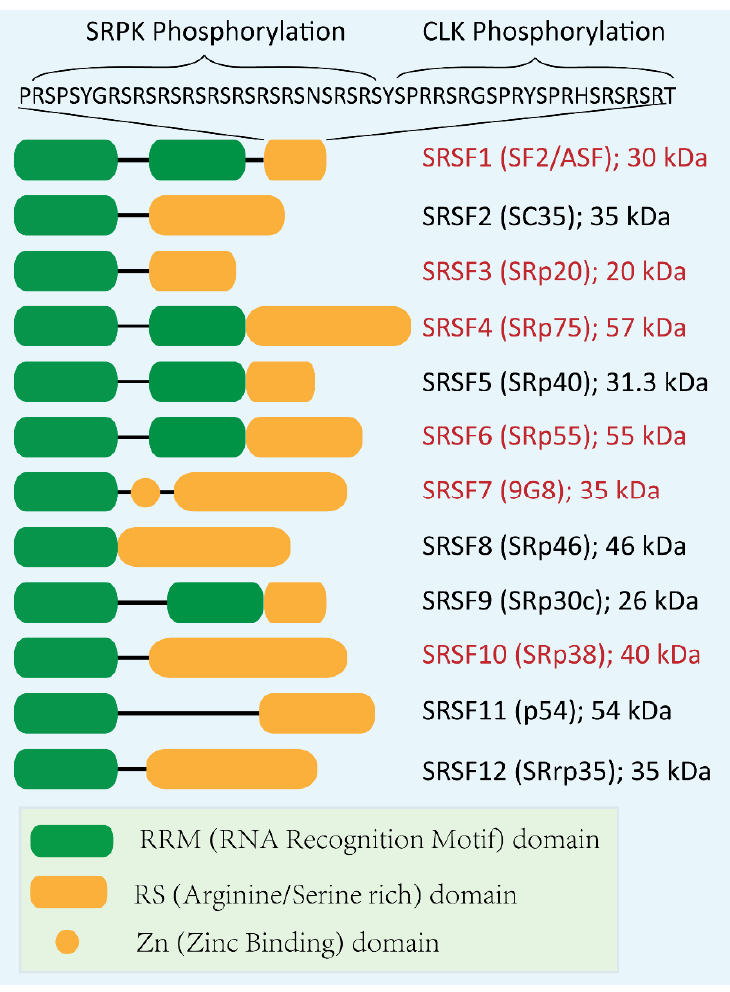
Figure 1. Schematic representation of the 12 human SR proteins. SR proteins are presented as SRSFs with aliases indicated in the parenthesis. Shuttling SR proteins (red letters) are reported to shuttle between nucleus and cytoplasm, whereas the others (black letters) have no shuttling activity. Phosphorylation of RS domain of SRSF1 by SRPK and CLK kinases is indicated as a representative at the top.